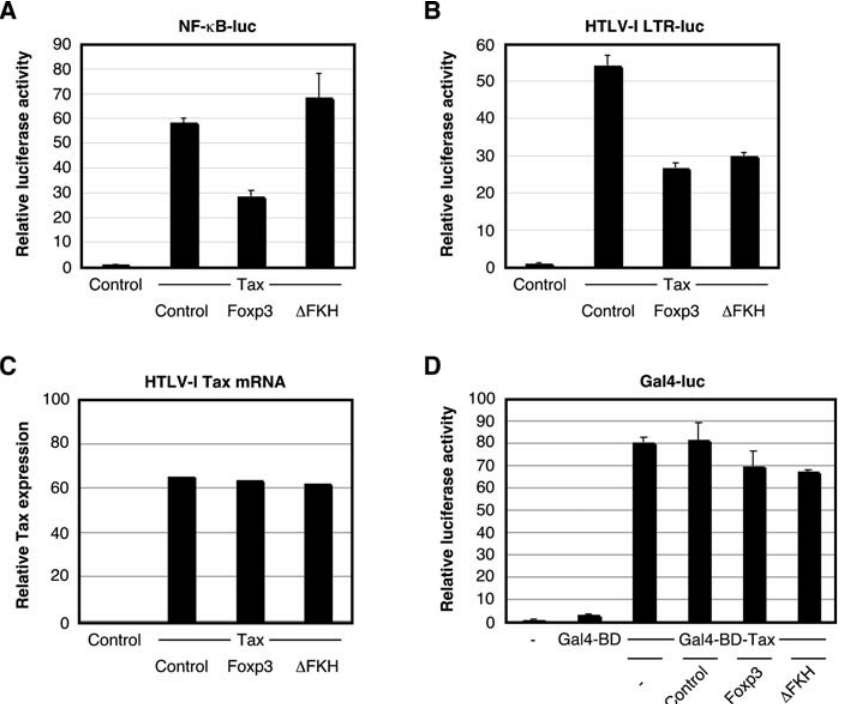
Figure 4. Transactivation Functions of HTLV-I Tax Are Blocked by Overexpression of Foxp3 (A and B) HEK 293T cells (5 3 10 5 ) were seeded into six-well plates 1 d prior to transfection with NF- j B (A) or HTLV-I LTR (B) luciferase reporter vectors (200 ng) in the presence or absence of an HTLV-I Tax, Foxp3, D FKH, or control expression vector (500 ng) and internal reference plasmid (pGL4- TKhRluc2; 50 ng). Cells were harvested at 24 h posttransfection and analyzed for luciferase activity. Relative luciferase activity was normalized to the internal reference control. (C) Expression of HTLV-I Tax in (A) and (B) was measured by quantitative RT-PCR (TaqMan) to demonstrate that Foxp3 did not suppress Tax transactivation of NF- j B and the HTLV-I LTR by down-regulating the expression of Tax. (D) HEK 293T cells (5 3 10 5 ) were seeded into six-well plates 1 d prior to transfection with a Gal4 luciferase reporter vector (200 ng) in the presence or absence of a Gal4-BD or Gal4-BD-Tax expression vector (500 ng), Foxp3, D FKH, or control expression vector (500 ng) and internal reference